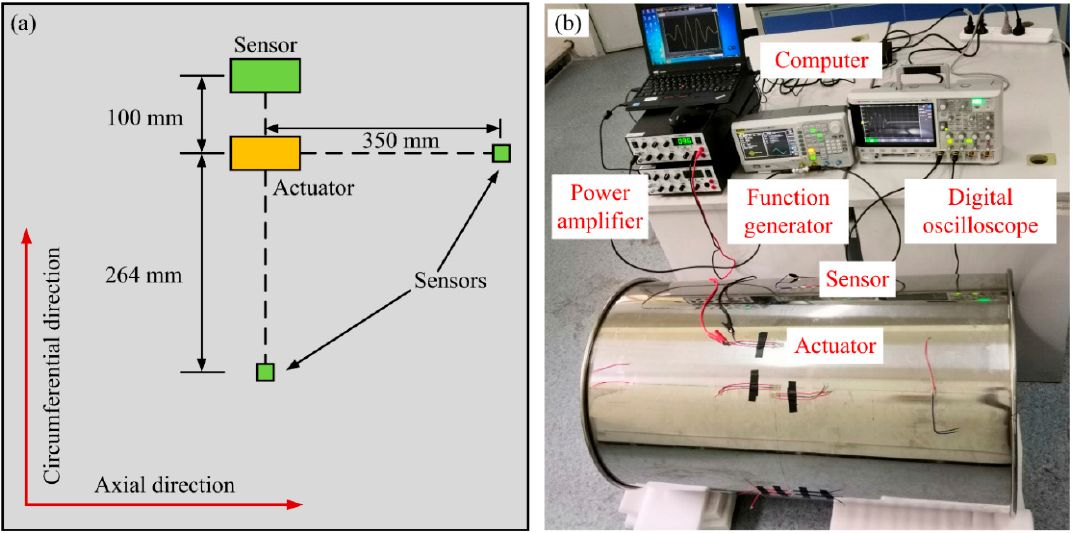
Figure 7. ( a ) Schematic of the experimental setup for exploring the bidirectional transducer’s performance on exciting and receiving CSH 0 wave. ( b ) The photo of the experimental setup.